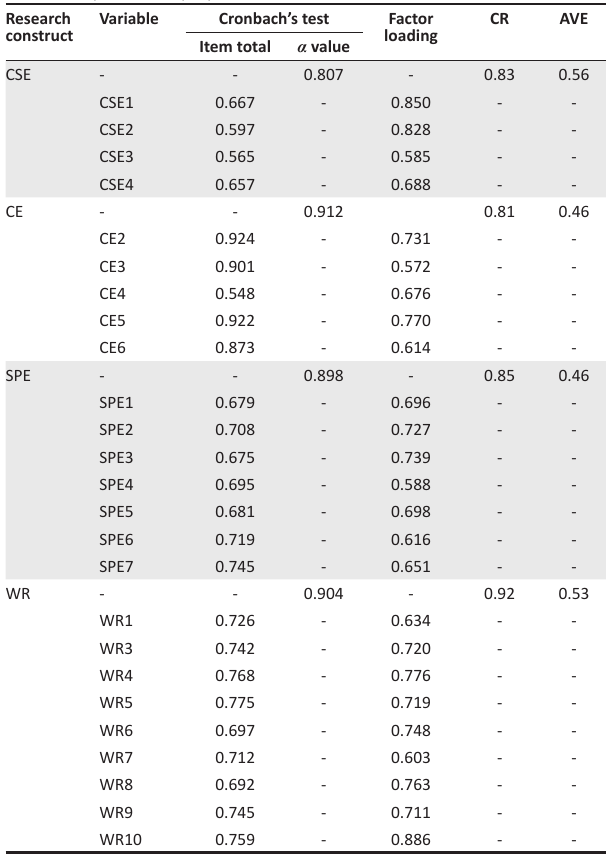
TABLE 2: Psychometric properties of measurement